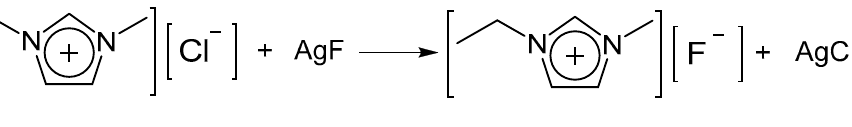
Figure 2. Synthesis process of [EMIm]F.